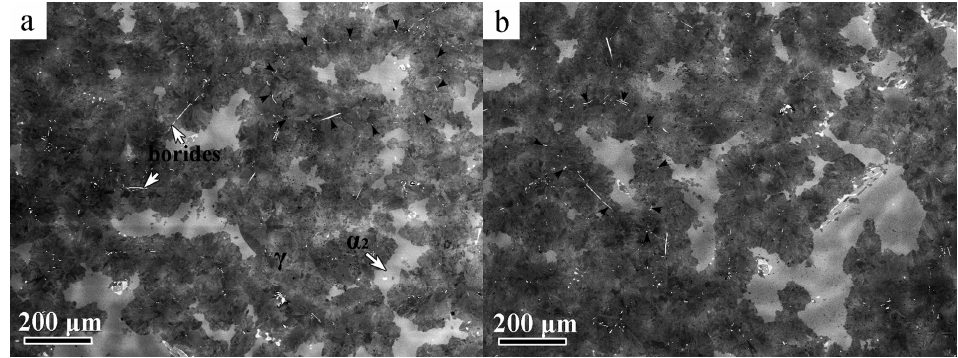
Figure 2. SEM images of the microstructures after heat treatment at 1340 °C for 30 min ( a ) and 2 h ( b ) followed by water-quenching; the arrowheads indicate the boundaries of the former α 2 phase at high temperature.